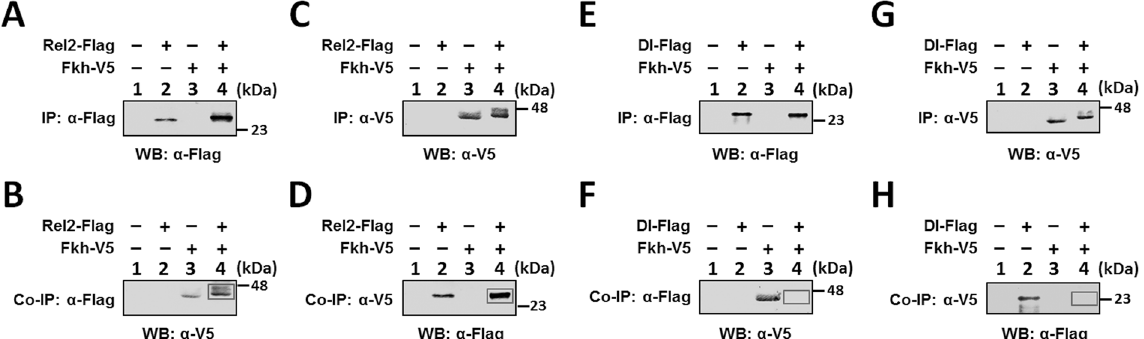
Figure 6. Interaction of M. sexta Fkh with Relish-RHD. Recombinant V5-tagged MsFkh, Flag-tagged MsRelish-RHD (MsRel2-RHD) and Flag-tagged MsDorsal-RHD (MsDl-RHD) were expressed in S2 cells separately, and cell lysates from two samples were mixed for co-immunoprecipitation (Co-IP) assays as described in the Materials and Methods. Immunoprecipitated (IP) proteins or Co-IP proteins were detected by immunoblotting using anti-Flag or anti-V5 monoclonal antibody as the primary antibody. Lanes 1–3 were cell lysates (protein inputs) from control S2 cells (lane 1), S2 cells overexpressing Flag-tagged MsRel2-RHD or Flag-tagged MsDl-RHD (lane 2), and S2 cells overexpressing V5-tagged MsFkh (lane 3), and lane 4 was IP or Co-IP proteins. V5-tagged MsFkh was co-immunoprecipitated with Flag-tagged MsRel2-RHD ( B and D , lane 4, boxed bands), but was not co-immunoprecipitated with Flag-tagged MsDl-RHD ( F and H , lane 4, boxes).